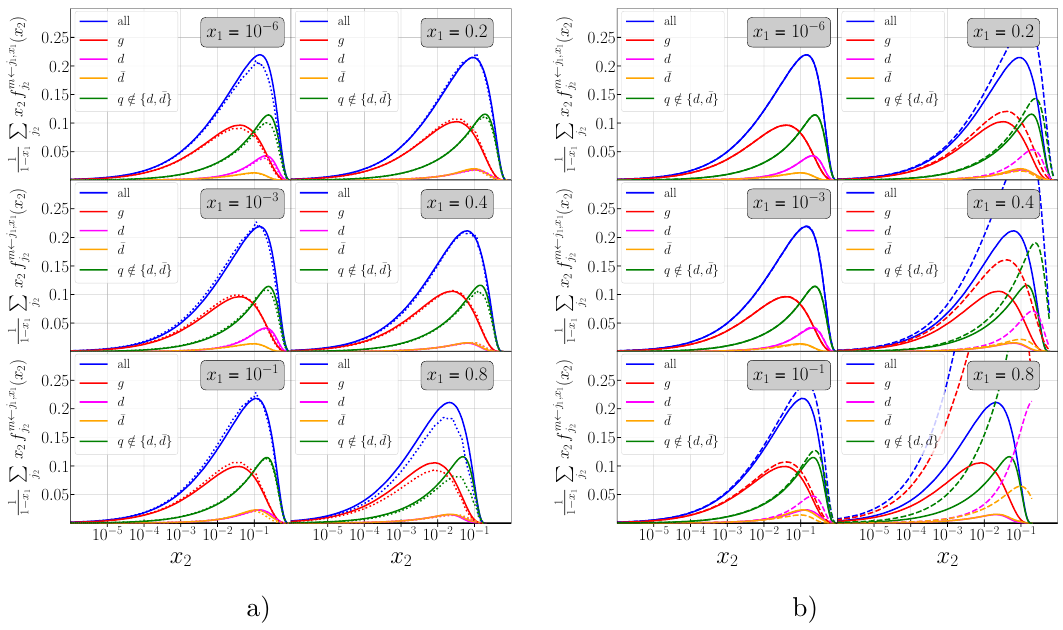
Figure 3 . Behaviour of the momentum sum rule response function, as defined in eq. (3.14), for the dPDF models considered. Solid, dotted and dashed lines correspond to the P YTHIA dPDFs, GS09 and naive dPDFs